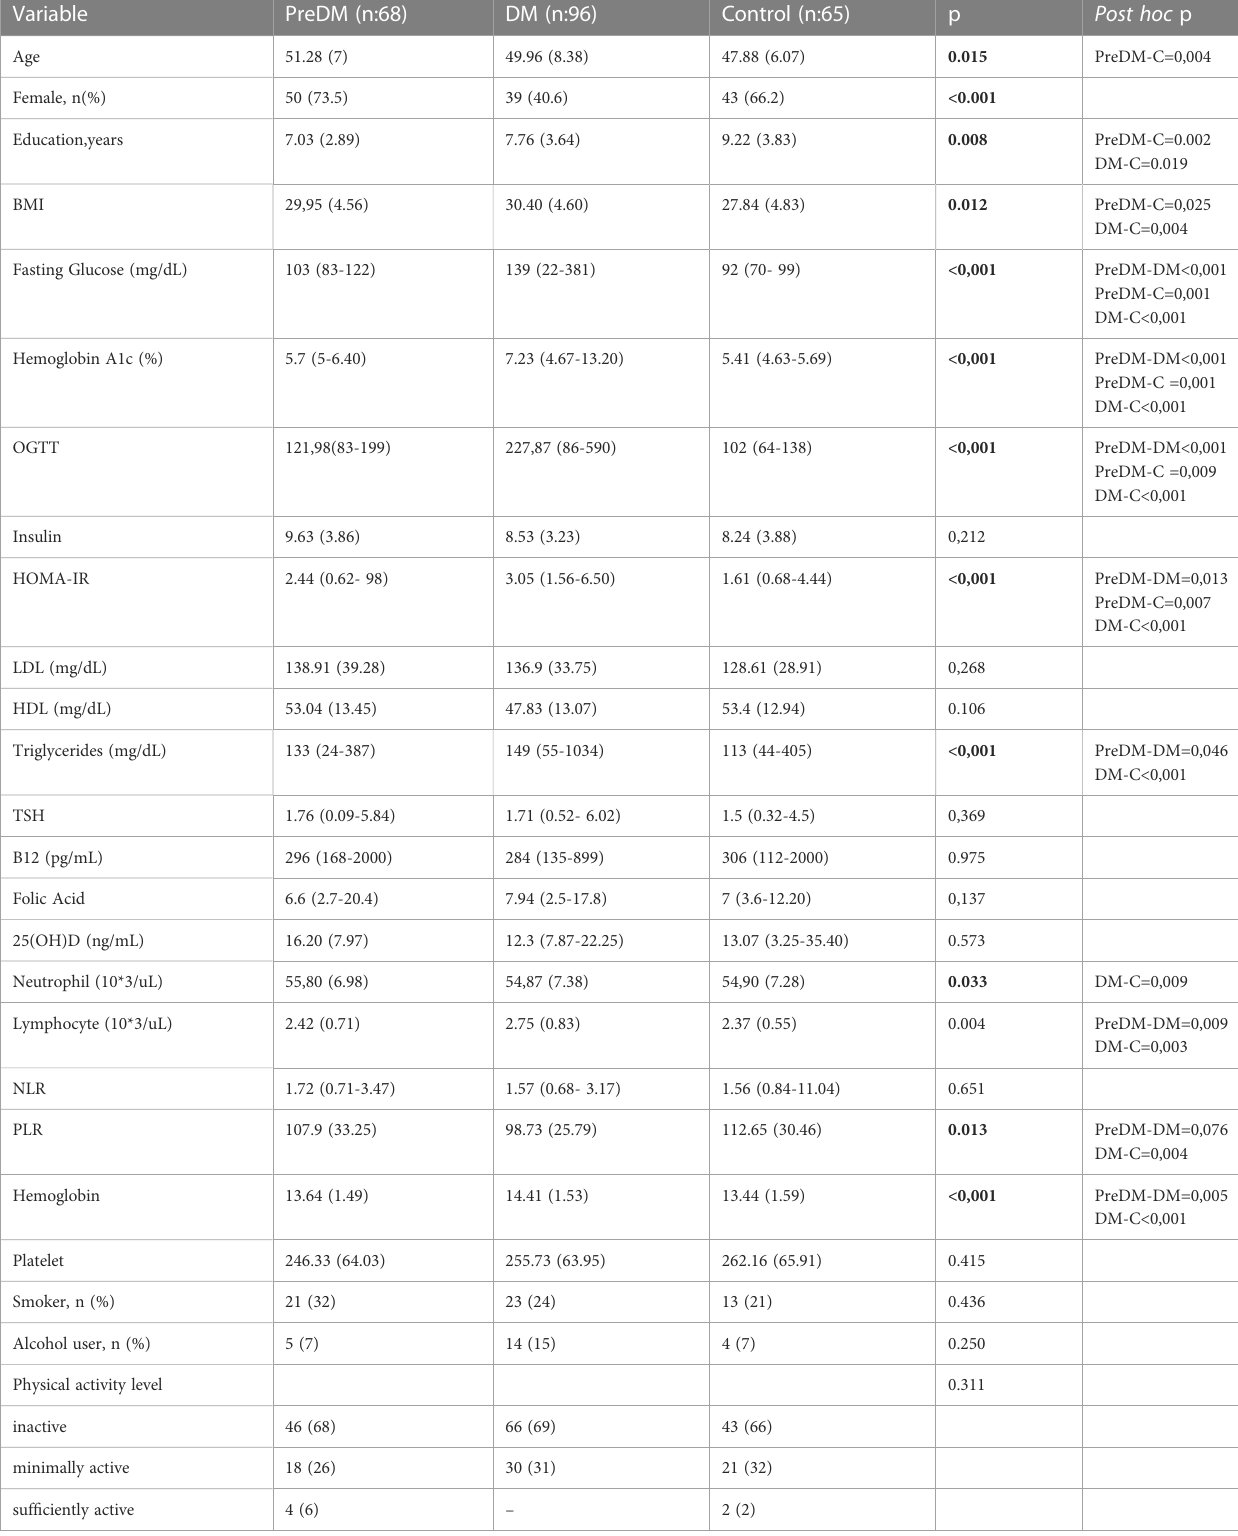
TABLE 1 Demographic and clinical characteristics of the